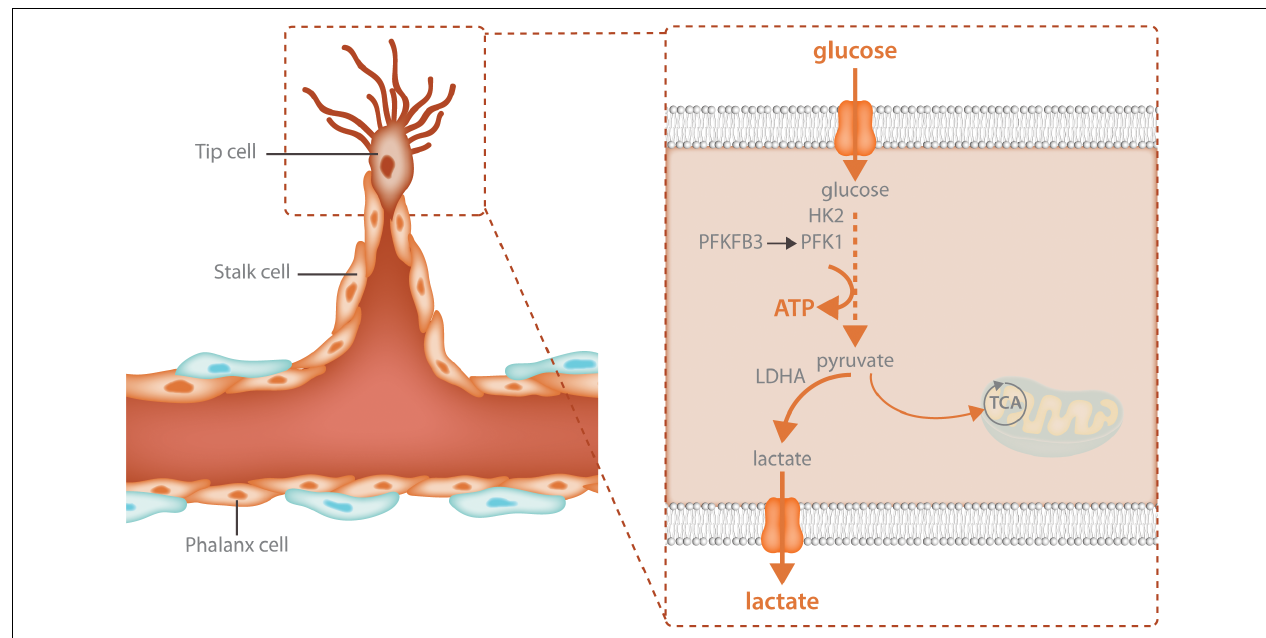
FIGURE 2 | Glycolysis fuels the migrating tip cell. Tip cells are dependent upon glycolytic ATP production and have even higher levels of glycolysis than other endothelial cells. Tip cells increase glycolysis through upregulation of the enzymes that control the rate limiting steps of the reaction: HK2 and PFKFB3. HK2 catalyzes the first reaction of glycolysis, the phosphorylation of glucose to glucose-6-phosphate while PFKFB3 produces fructose-2,6-bisphosphate, the main allosteric activator of PFK1. The majority of the pyruvate that is produced during glycolysis is further broken down into lactate while only 1% ends up in the TCA cycle. High glycolytic flux provides increased local ATP production for the energetically demanding cytoskeletal rearrangements involved in cellular